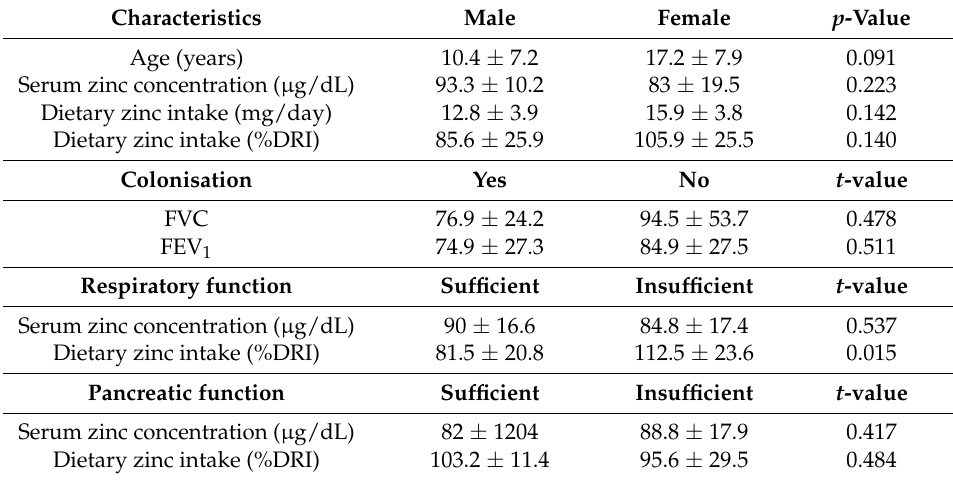
Table 3. Differences between fibrosis cystic